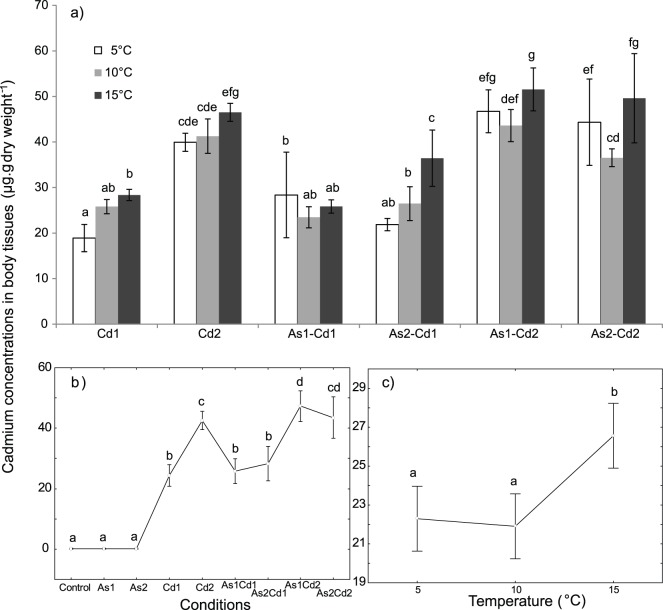
Mean cadmium concentrations in G. pulex body tissues (µg. g dry weight−1).Concentrations obtained for individuals exposed 96 h to different conditions (control, arsenate, cadmium and four binary mixtures) at three temperatures (5-10-15°C). a) Temperature × condition effect
. Mean internal Cd concentrations in G. pulex for each tested condition and temperature. Vertical bars represent standard deviations. b) Condition effect: Weighted mean concentration of internal Cd for each tested condition (results for all the tested temperatures were combined). Vertical bars represent 0.95 confidence intervals. c) Temperature effect: Weighted mean concentration of internal Cd for each temperature (results for all the tested conditions were combined). Vertical bars represent 0.95 confidence intervals. Letters (a to g) were used as labels to illustrate significant differences in mean [Cd] values (two-way ANOVAs + LSD Fisher post hoc tests; at p<0.05 level of significance).